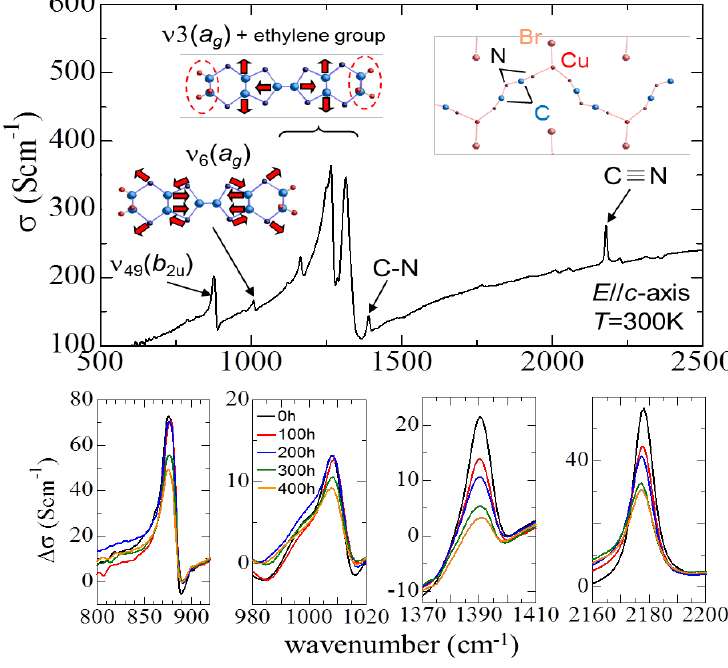
Figure 2. The infrared optical conductivity ( E // c -axis) in the finger-print photon energy region of κ-(BEDT-TTF) Cu[N(CN) ]Br at 300 K [33]. In the lower figures, changes of the 2 2 molecular vibration modes with X-ray irradiation are shown after subtracting the smooth background of